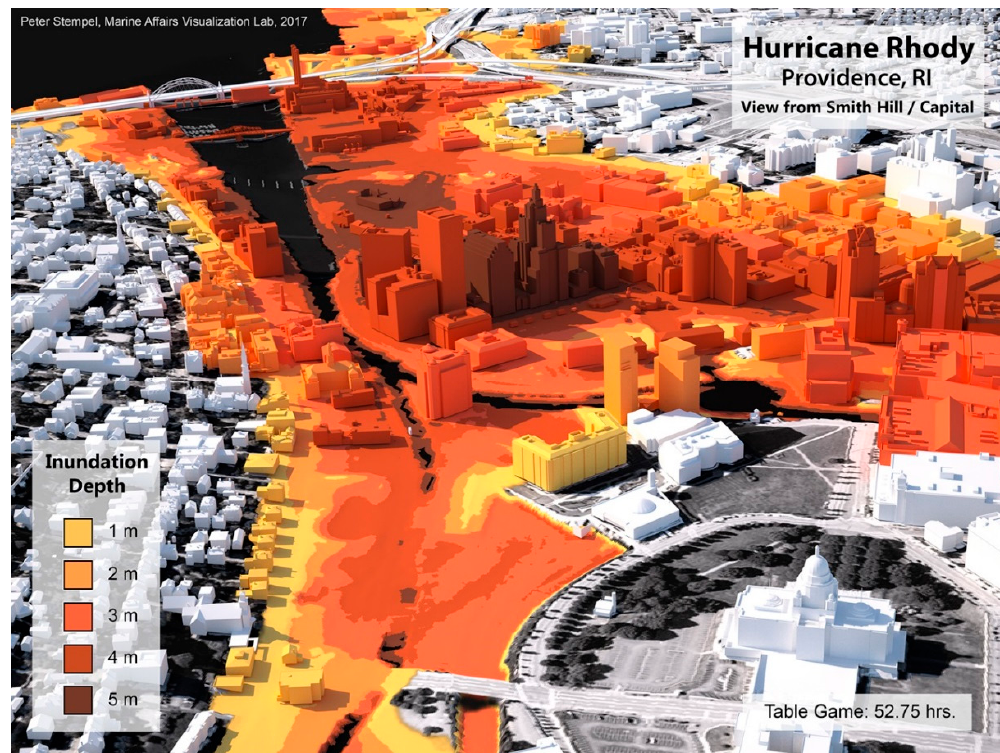
Figure 4. A FEMA IEMC visualization of downtown Providence, RI, USA as a result of failed flood control systems and 46" of rainfall [5,42]. The unfolding of this scenario requires the alignment of several events (e.g., failure of flood control measures); without this qualification, this visualization could foster a range of misleading interpretations. The term “Table Game” used in the visualization is a reference to the specific time increments of the exercise (visualizations made in series). Image: Authors.